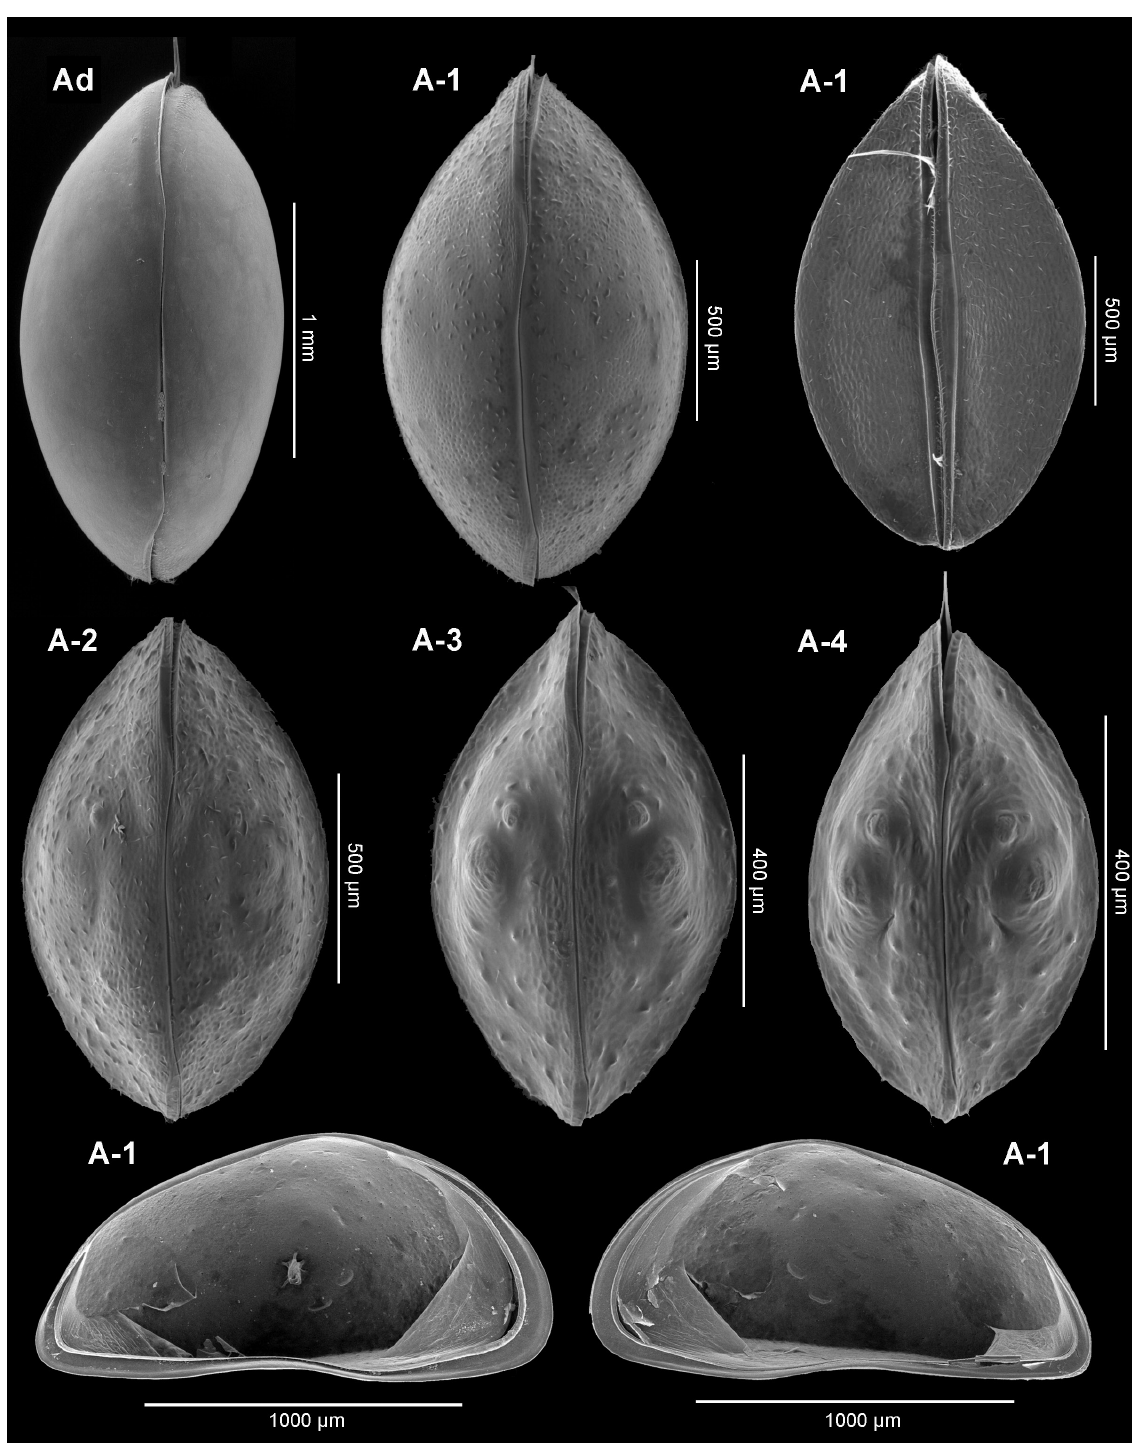
Fig. 11. Bennelongia sp. 414 nov. sp. from locality CB35a at Wooramel Station (Halse et al . 2000). For the top two rows, all views are dorsal, except top right image which is a ventral view. The bottom row consists of internal views of the two valves of an A-1 specimen. Note that the domes are only visible in A-2, A-3 and A-4 specimens, with possibly a second set of smaller ones positioned anterior to the larger one. The cones, which are few in number, are also very small and only clearly visible in A-3 and A-4